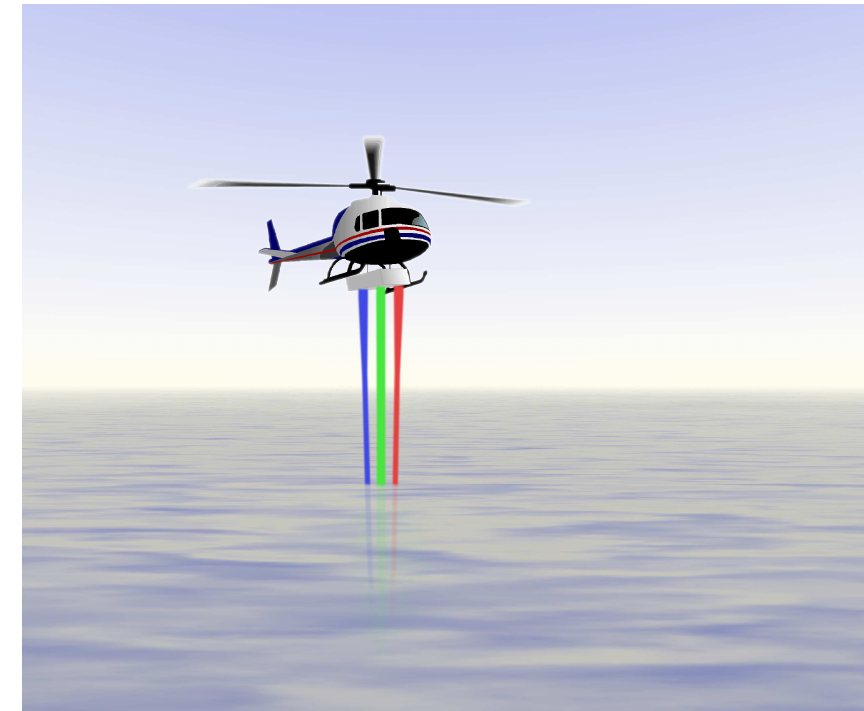
Figure 1: Vision of the Brillouin lidar mounted under a helicopter. The green ray depicts the laser pulse being sent into the ocean. The red and blue rays represent the two Brillouin shifted parts of the backscattered light whose frequencies are slightly red- and blue shifted with respect to the laser